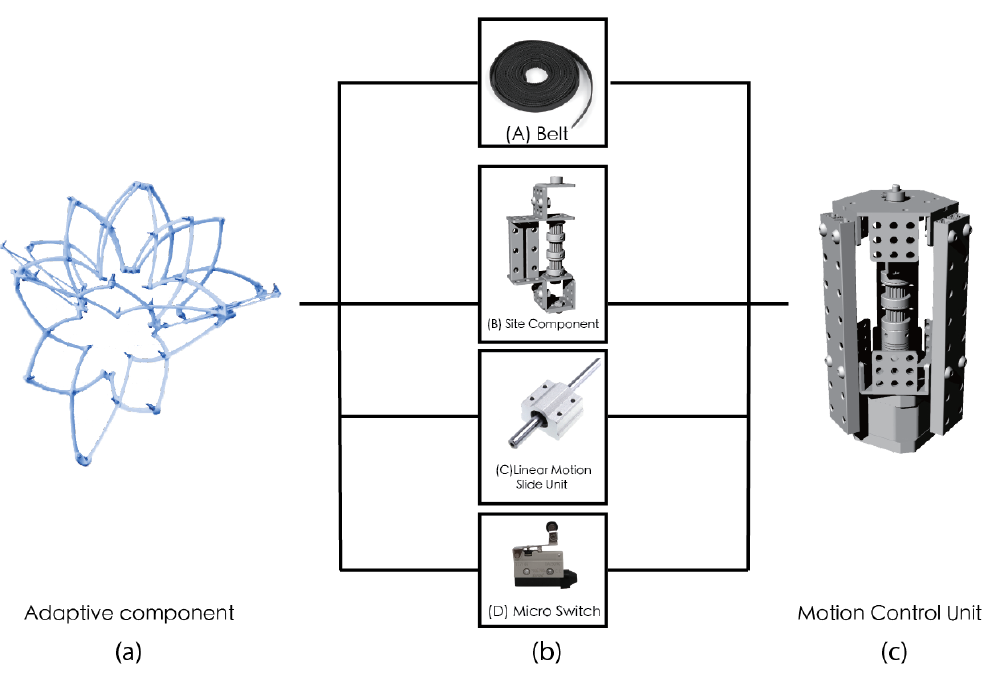
Figure 6. ( a ) Adaptive component configuration prototype model based on the scissor truss; ( b ) MakeBlock components for kinetic motion; and ( c ) central motion control unit.